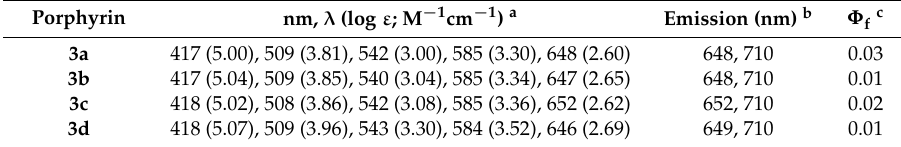
Table 2. Absorption and emission data of porphyrin derivatives 3a – d .